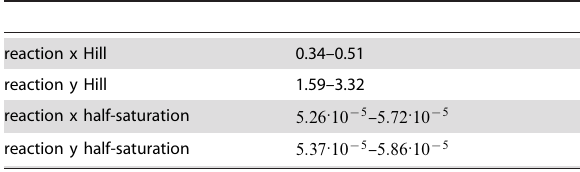
Table 1. Evolved solutions for the network in fig. 5